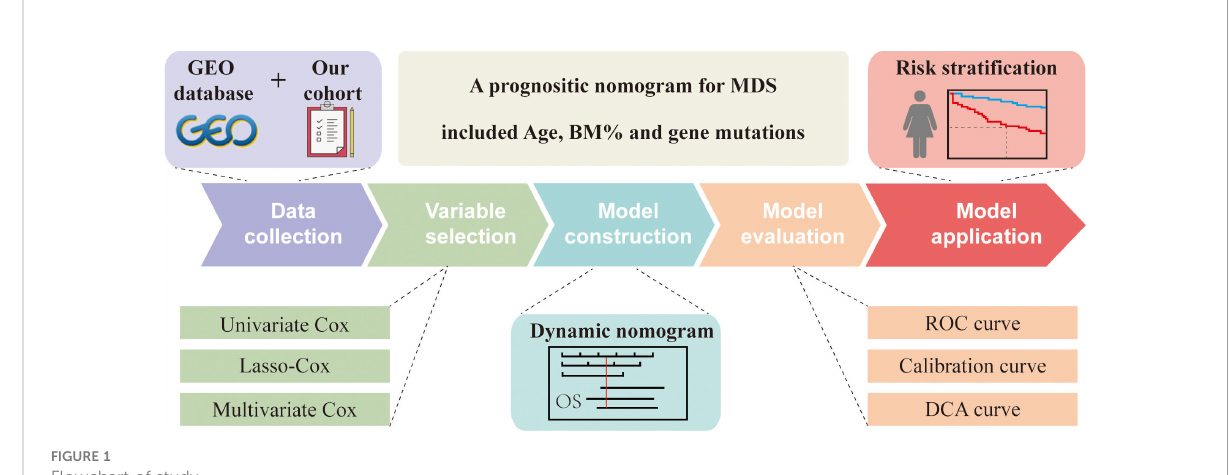
FIGURE 1 Flowchart of